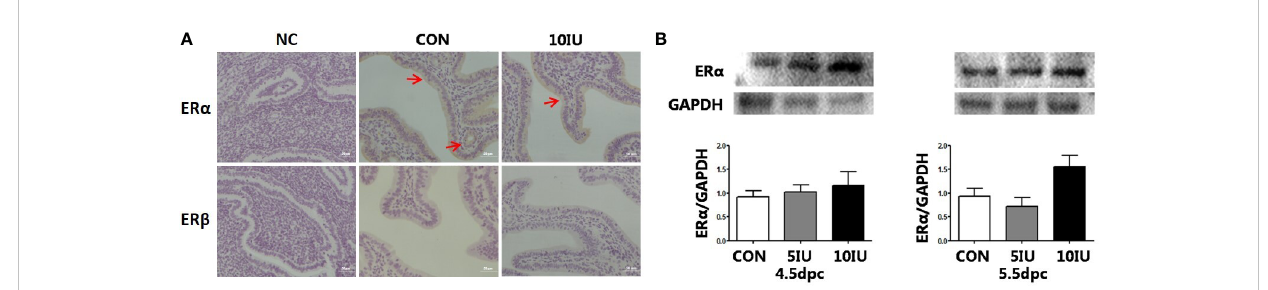
FIGURE 4 The localization and protein expression of the oestrogen receptors ER a and ER b in the mouse endometrium at 4.5 dpc and 5.5 dpc in the CON, 5 IU and 10 IU groups. (A) Localization of ER a and ER b in the endometria of mice at 5.5 dpc. Bar=50 m m. (B) : Protein expression of ER a in the endometria of mice in the CON, 5 IU and 10 IU groups at 4.5 dpc and 5.5 dpc. NC, negative control. The arrows indicate the localization of target protein.